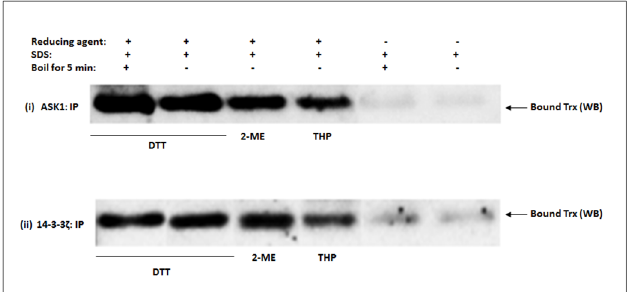
Fig 7. Effect of disulfide reducing agents on the dissociation of Trx from Trx bound ASK1 and/or 14-3- 3 ζ complex. The ASK1 signaling complex was co-IP using ASK1 or 14-3-3 ζ antibody. Chemical dissociation of co-precipitated Trx from the complex was monitored in the presence or absence of various disulfide reducing agents in SDS- conditioned buffer as described in the text. DTT, dithiothreitol; 2-ME, 2-mercaptoethanol; THP, tris(hydroxypropyl)phosphine. The experiment was repeated at least twice and a representative Western blot is shown. A representative full blot image showing higher molecular weight protein complexes is shown in S1